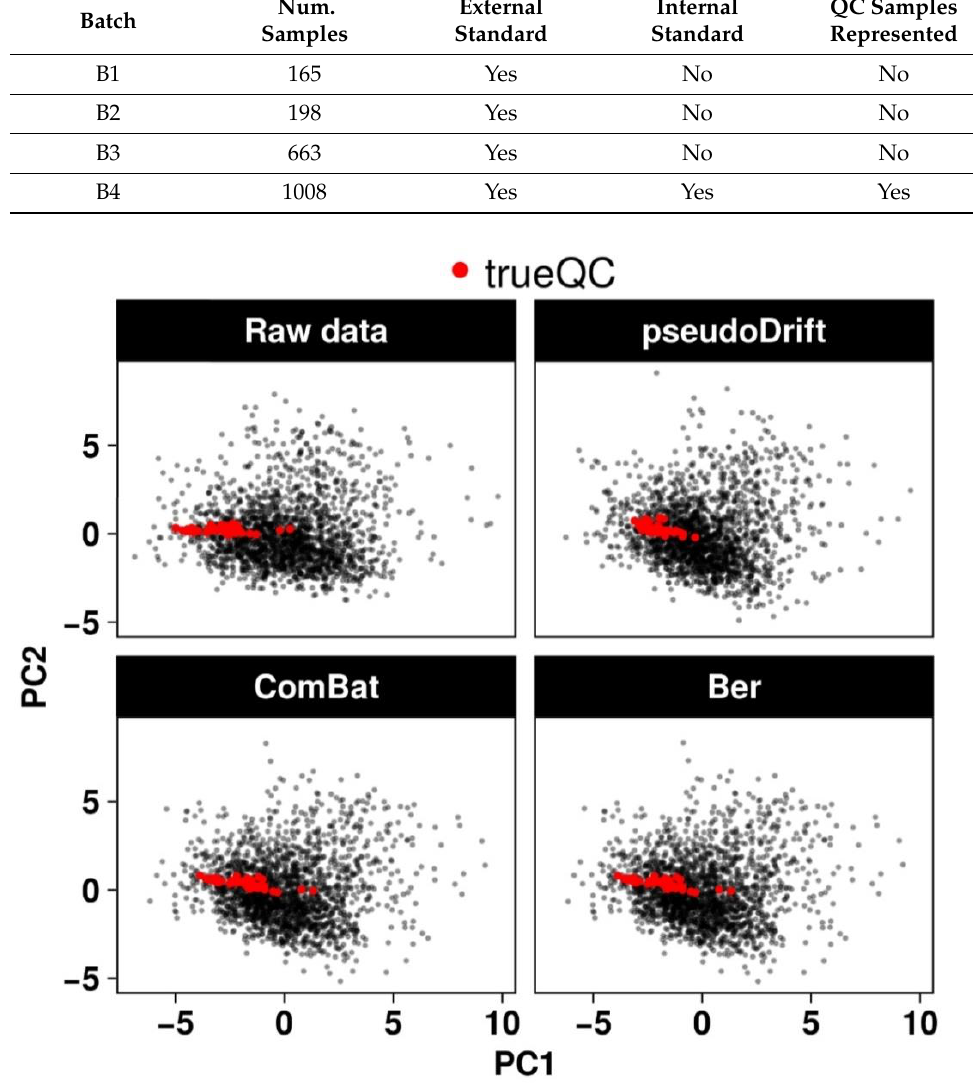
Figure 4. Comparison of different non-QC-based corrections applied to the maize LC–MS peak area matrix. The correction method and resultant peak area matrix used to calculate the first two PCs is labeled on each respective bi-plot. The maximum distance (maxDist) represents the largest distance between any two trueQC points in the